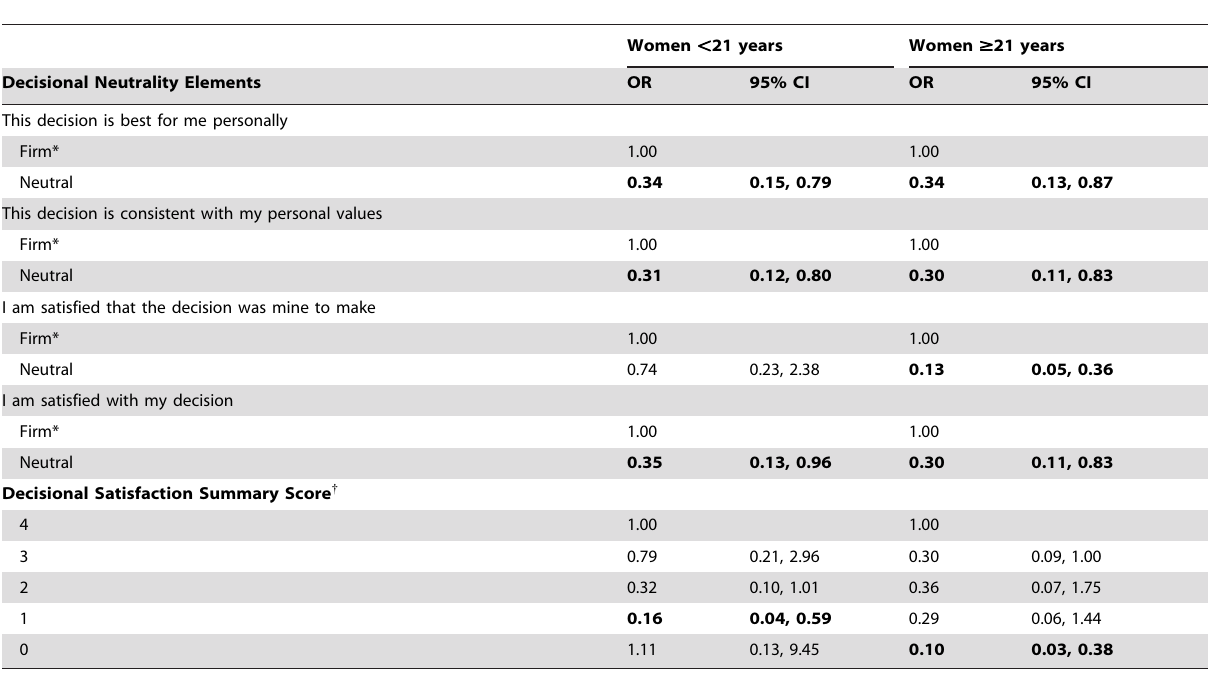
Table 4. Predictors of intent to participate in cervical cancer